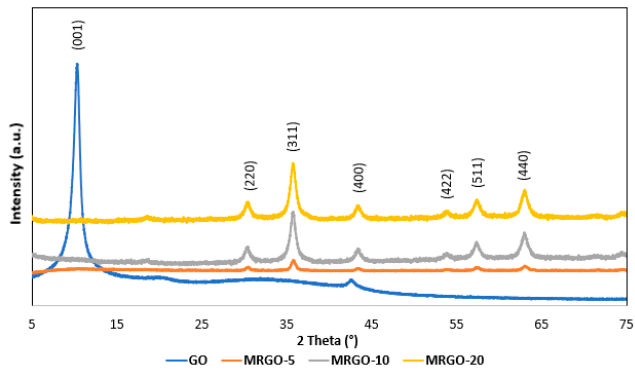
Figure 3. XRD analysis of GO, MRGO-5, MRGO-10 and MRGO-20.